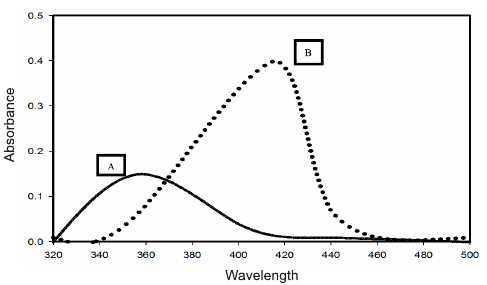
Fig. 4. UV–visible spectra (320–500 nm) of extracted pyoverdine from the secondary metabolites of P. aeruginosa DM1 grown without addition of zinc nitrate (A) and with addition of zinc nitrate (200 mg L -1 ).